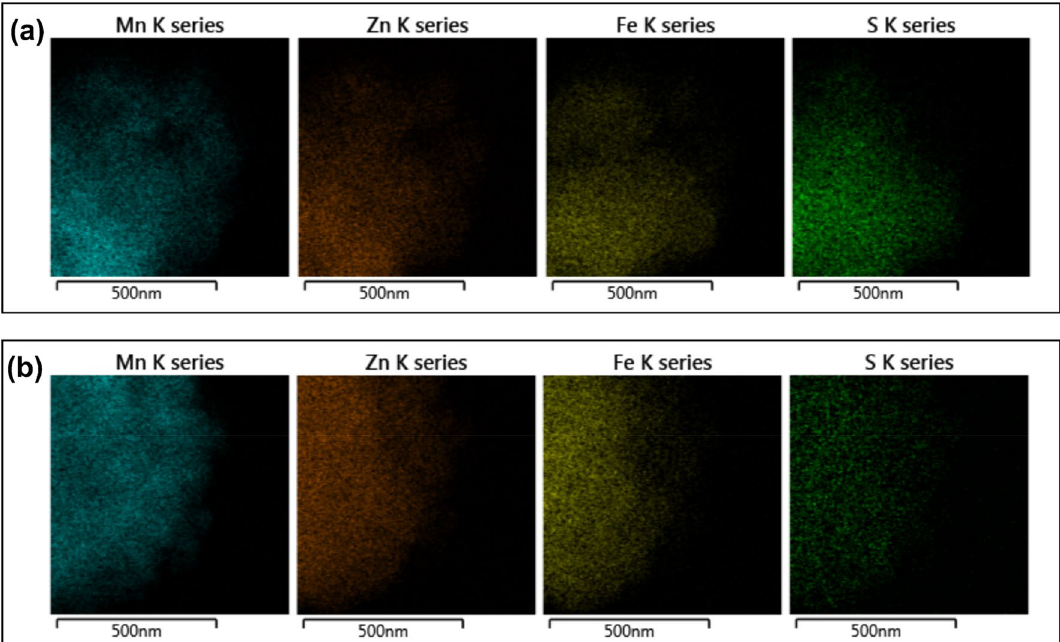
Figure 6. 2D elemental mapping of wet MFZO after ( a ) H 2 S; ( b ) SO 2